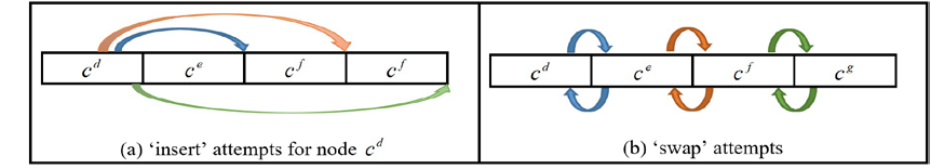
Figure 3. An illustration of Intra-Route Local Search. ( a ) ‘insert’ attempts for node c d ; ( b ) ’swap’ attempts.